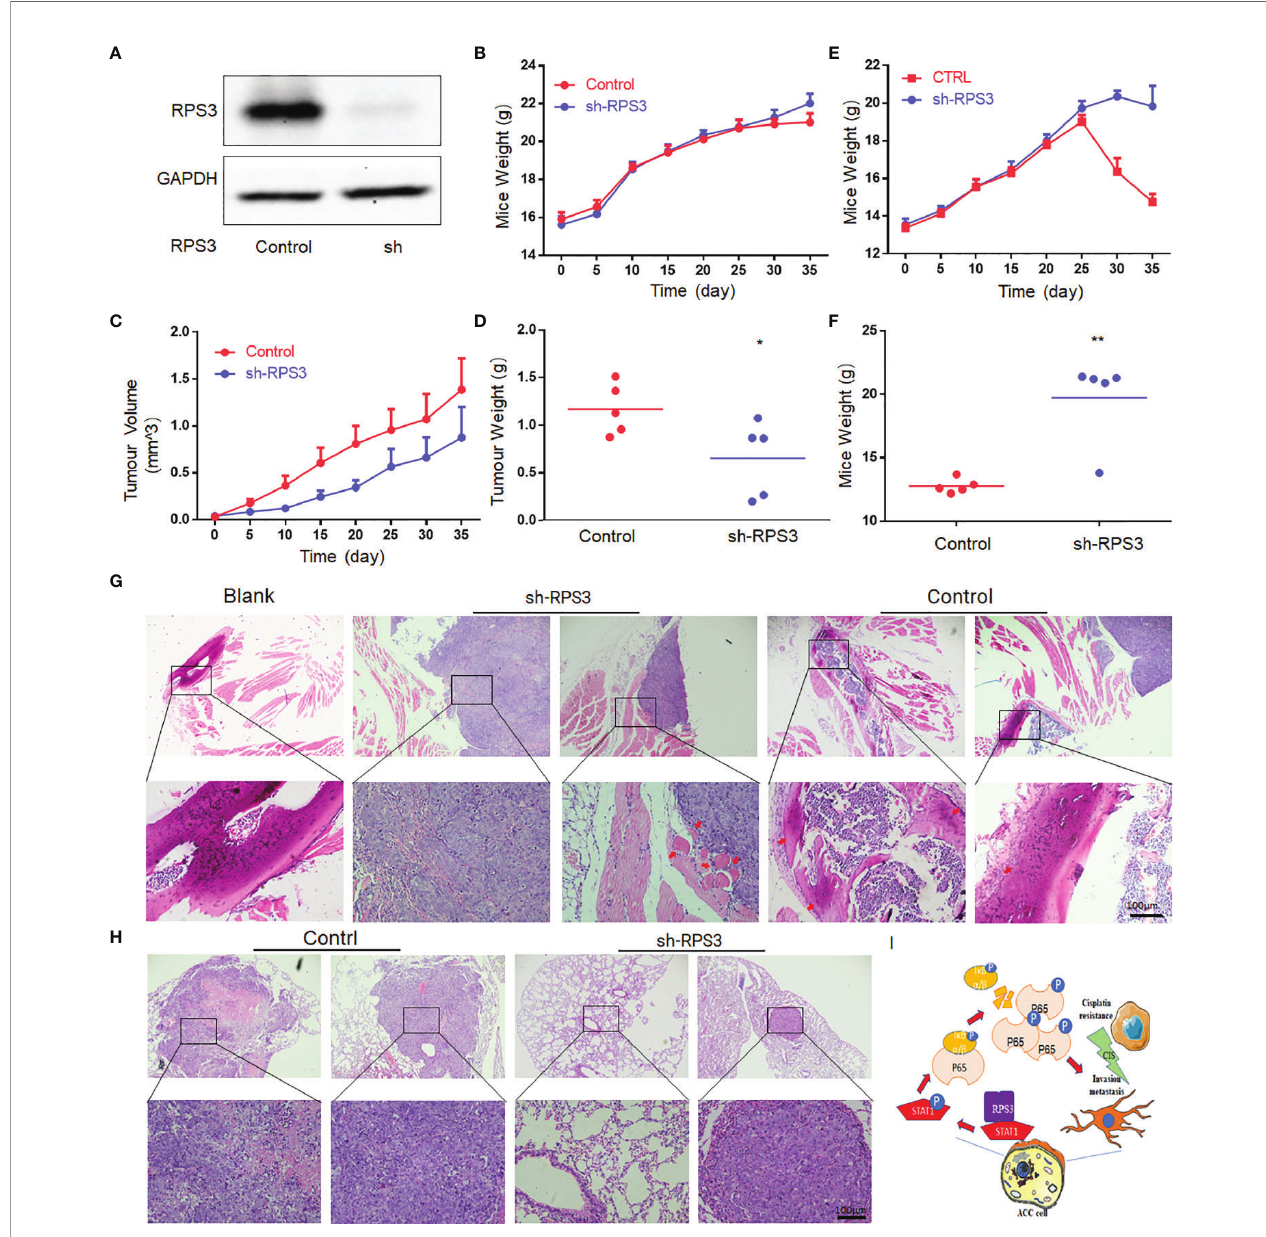
FIGURE 7 | Knockdown of RPS3 inhibited ACC invasion of the sciatic nerve and lung metastasis in nude mouse model. (A) Western blot veri fi es that a stable RPS3 knockout ACC-LM cell line was successfully constructed. (B) Weight change curve of in the sciatic nerve invasion nude in the mouse model. (C) Tumor growth curve of the sciatic nerve invasion nude mouse model. (D) The tumor weight of the mice in the knockdown RPS3 group was lower than that in the control group (P<0.05). (E) Weight change curve of nude mouse model of lung metastasis. (F) The weight of the mice in the knockdown RPS3 group was signi fi cantly higher than that in the control group (P<0.05). (G) HE staining was used to observe the tumor and sciatic nerve (red arrows point to nerves. In the RPS3 knockdown group, there was no sciatic nerve around some tumors, and some tumor tissues compressed the nerve but did not surround the nerve. while the tumor in the control group wrapped the compressed nerve, and the nerve was twisted and deformed, and even tumor tissue in fi ltration was observed in some nerves. (H) HE staining showed the tumor tissue of the control group and the sh-RPS3 group; some mice in the sh-RPS3 group did not have tumors. (I) Schematic model of the mechanism by which the RPS3/STAT1/NF-kB signaling pathway regulates cisplatin resistance and migration-invasion behavior of ACC cells. * P < 0.05;* * P <